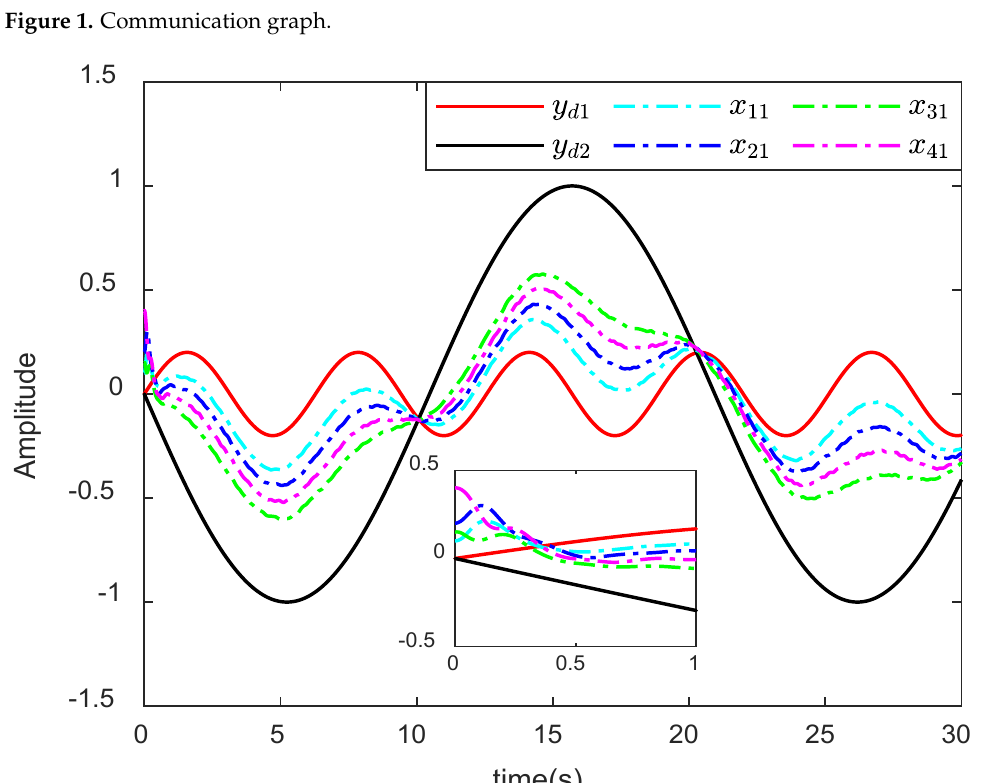
Figure 2. The trajectories of y d